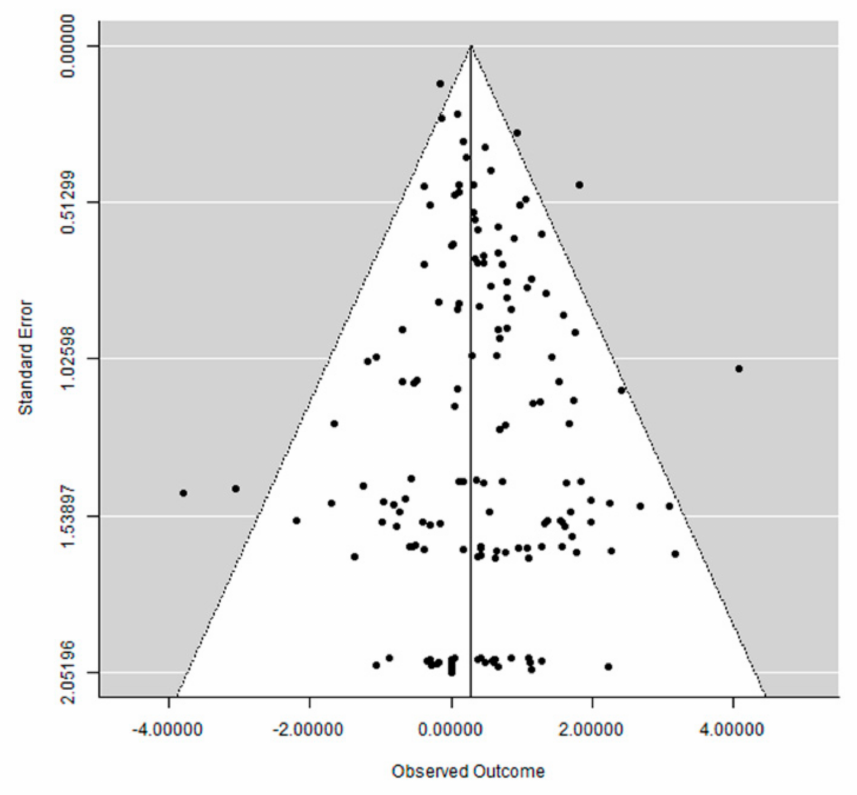
Figure 9. Funnel